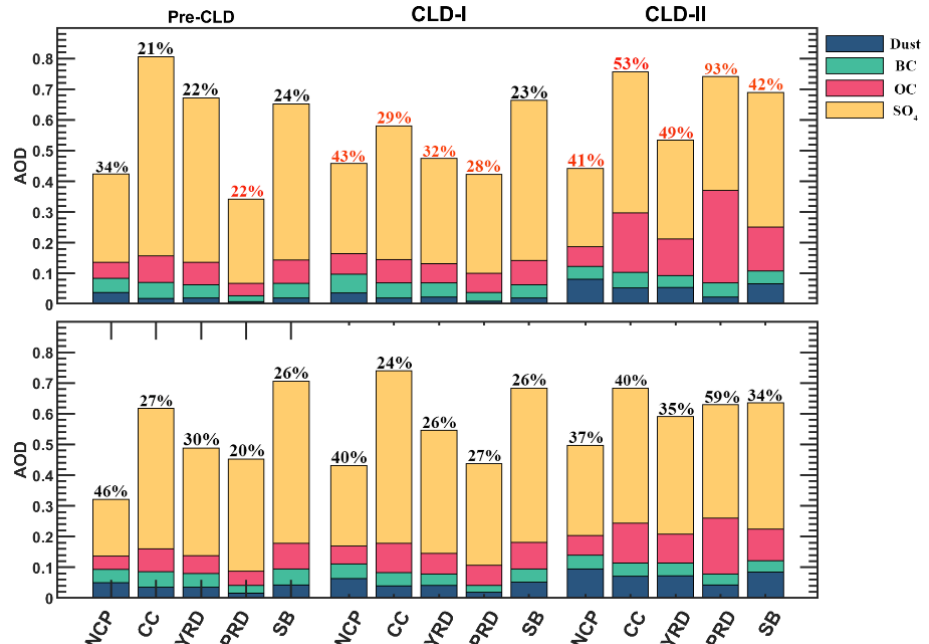
Figure 7. AOD of dust, BC, OC, and SO 4 in NCP, CC, YRD, PRD, and SB in 2020 and the average value of previous years (2017–2019). The percentage on the bar represents (BC + OC)/(BC + OC + SO 4